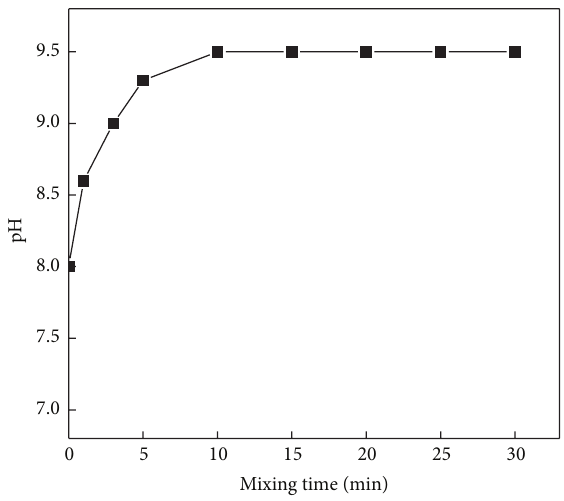
Figure 1: pH value as a function of mixing